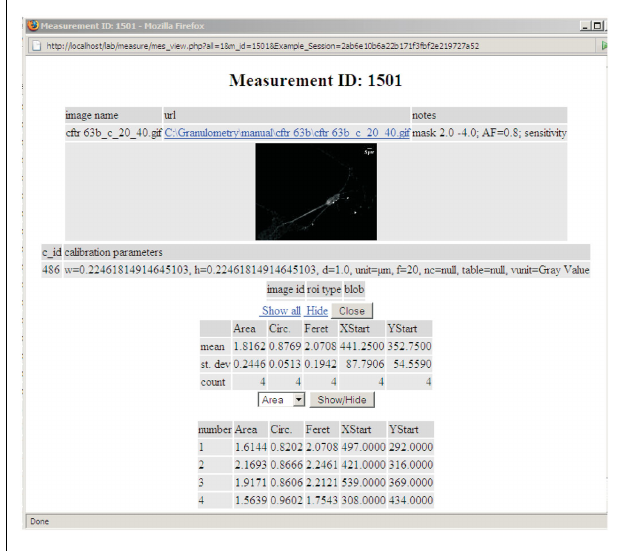
FIGURE 2 |The measurement